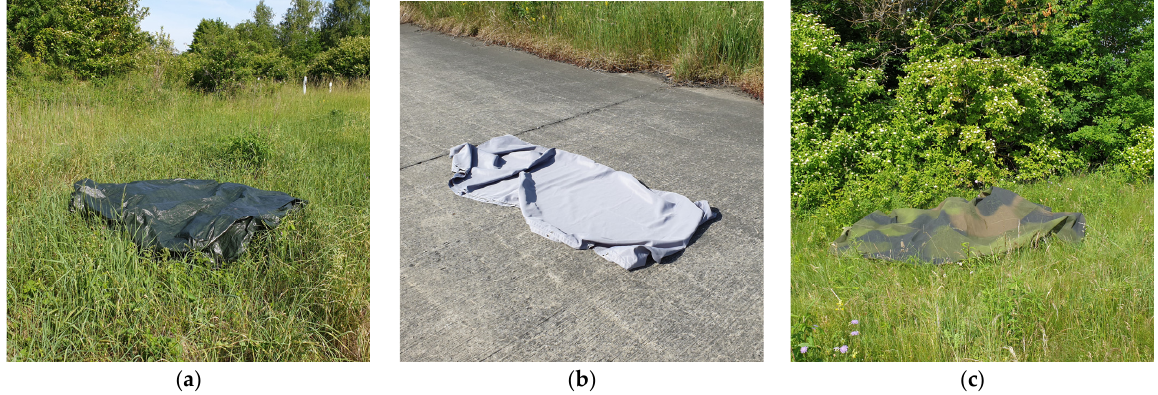
Figure 4. Three targets of MUCAD from ground perspective. ( a ) Green tarpaulin (1); ( b ) grey tarpaulin (3); ( c ) 2D camouflage net (2). Numbers refer to Figure